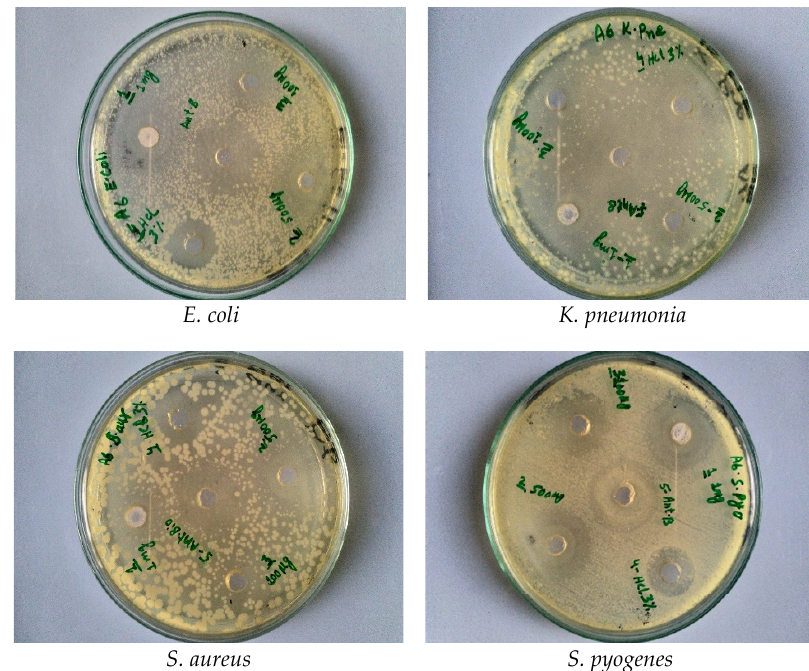
Figure 10. Zone of inhibition (ZOI) formed by Co-doped ZnO microcrystals against different bacte- ria.